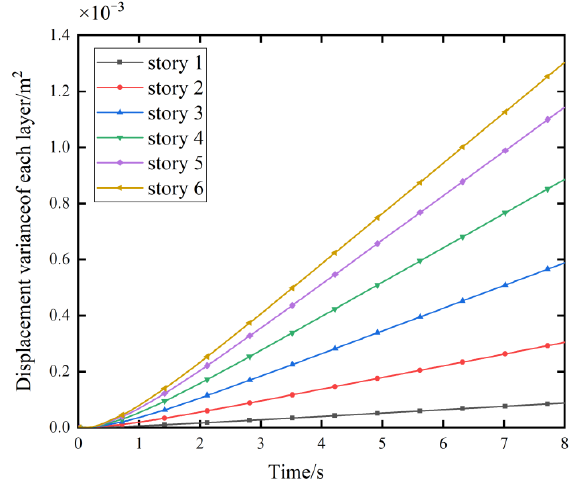
√ t : time-dependent displacement variance. Figure 9. g ( t ) = Figure 9. ( )= g t t : time-dependent displacement variance. Table 2. Optimization of additional damping. Table 2. Optimization of additional damping.